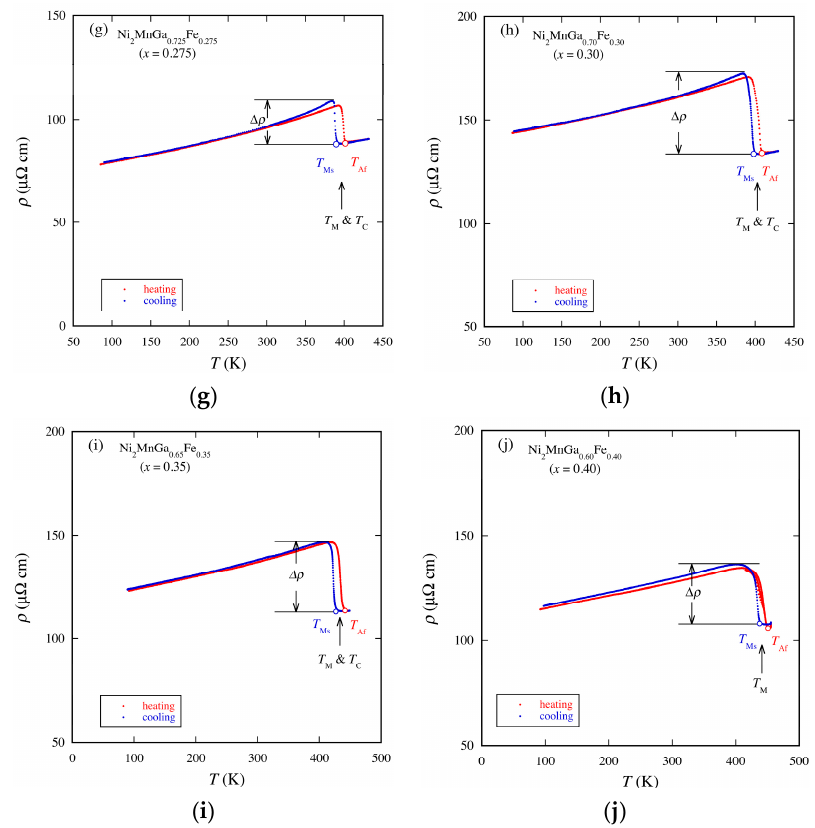
Figure 1. Temperature dependences of the electrical resistivity ρ for Ni 2 MnGa 1– x Fe x ( x = 0.025–0.40). The inset shows the temperature dependence of d ρ /d T . ( a ) Ni 2 MnGa 0.95 Fe 0.05 ( x = 0.05);